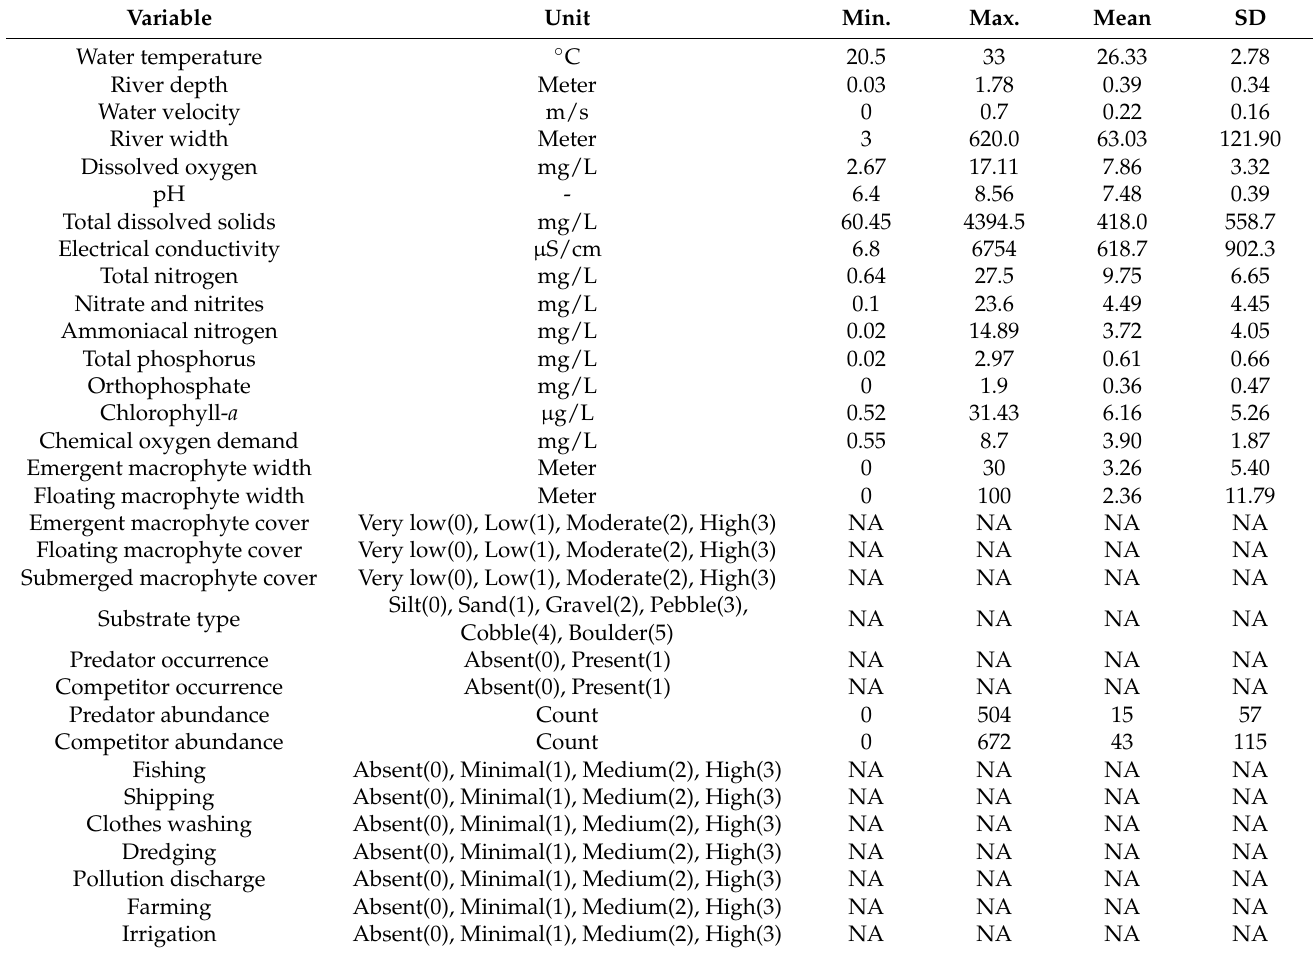
Table 1. Input variables used for model development: minimum values, maximum values, mean values, and standard